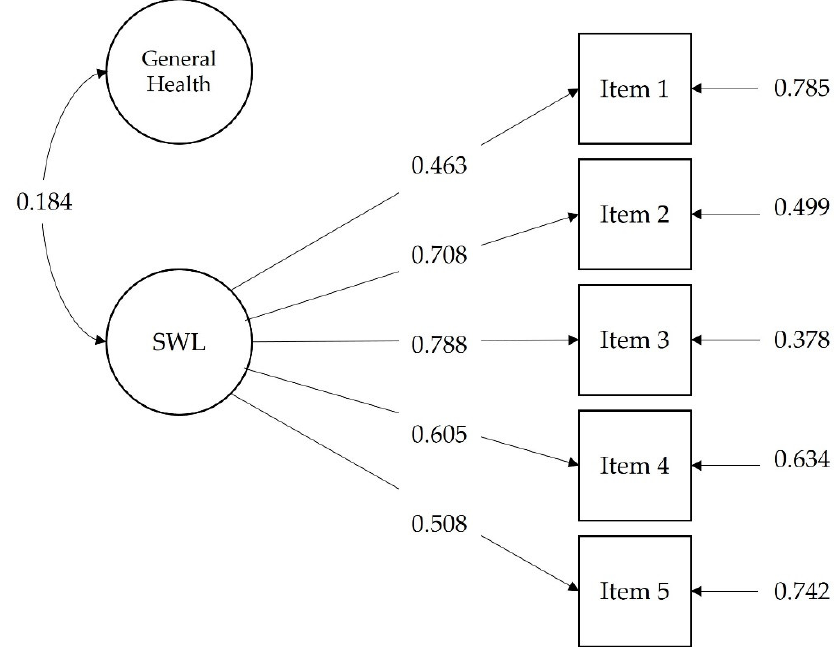
Figure 2. Path model for the association of the Satisfaction with Life Scale (SWLS) with the General Health item. Standardized coefficients are shown.